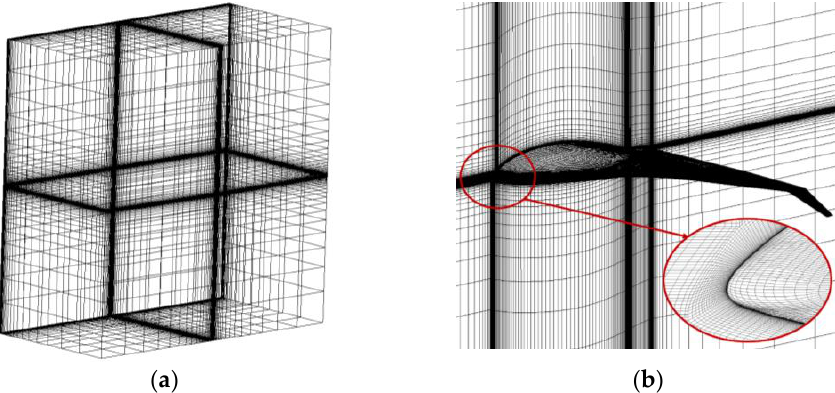
Figure 7 . Computational mesh around the half model of the present BWB configuration. ( a ) Computational domain. ( b ) BWB surface mesh and center plane cells near LE.